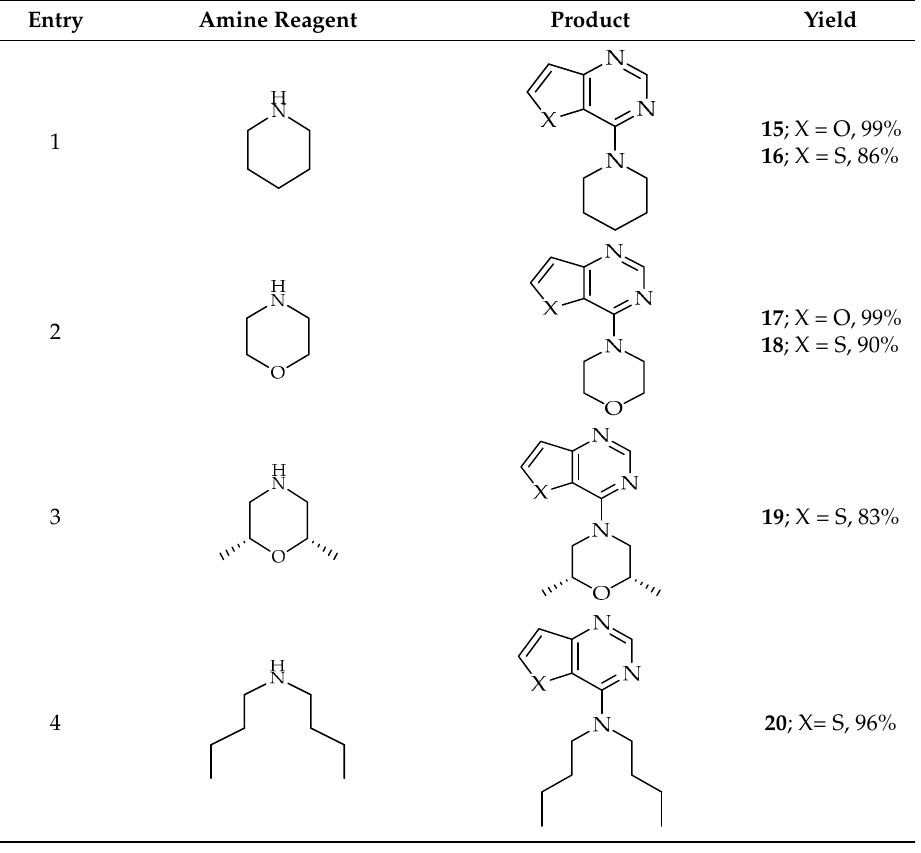
Scheme 1. Synthesis of 1 – 6 . Reagents and conditions : (i) amino derivative (2 equiv.), PEG400, 120 °C, 5 min, 70–95%. Table 1. Results of the S N Ar on 4-chloro-2-methylimidazo[1,5- a ]pyrimidine-8-carbonitrile with various amines. Table 4. Results of the aromatic nucleophilic substitution (SNAr) on 4-chlorofuro and thieno[3,2- d ]pyrimidine.